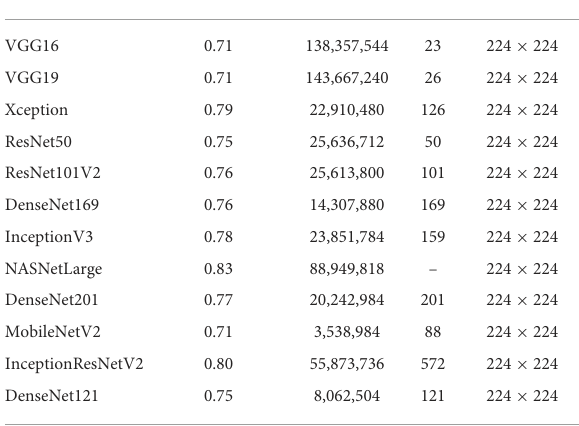
TABLE 2 Information on the pre-trained models used in this study.